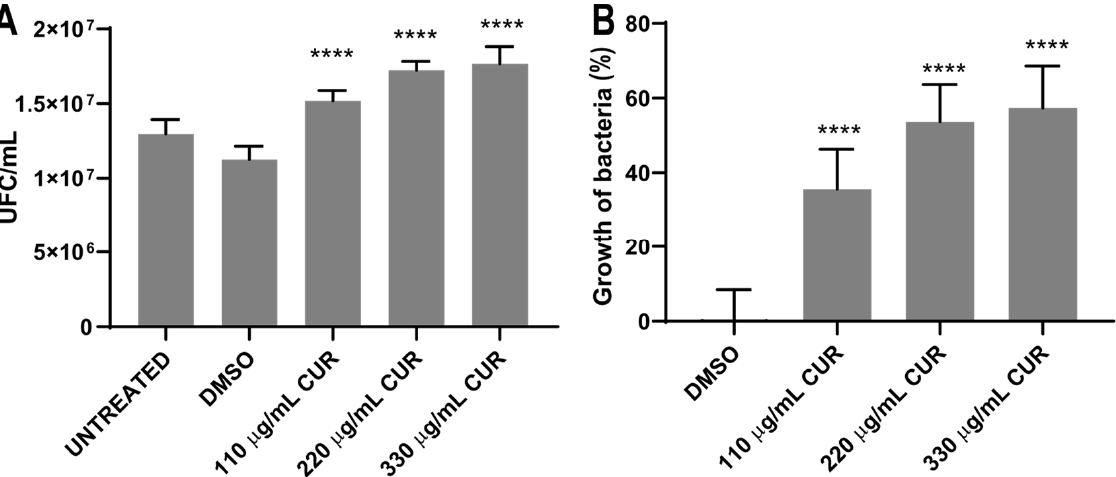
Figure 3 . Number of colonies on agar plates ( A ) and percentage growth of S. enterica ser. Typhimurium ( B ), after treatment with CUR. The average and standard deviation values of six replicates are shown for the strain. (**** p < 0.0001).